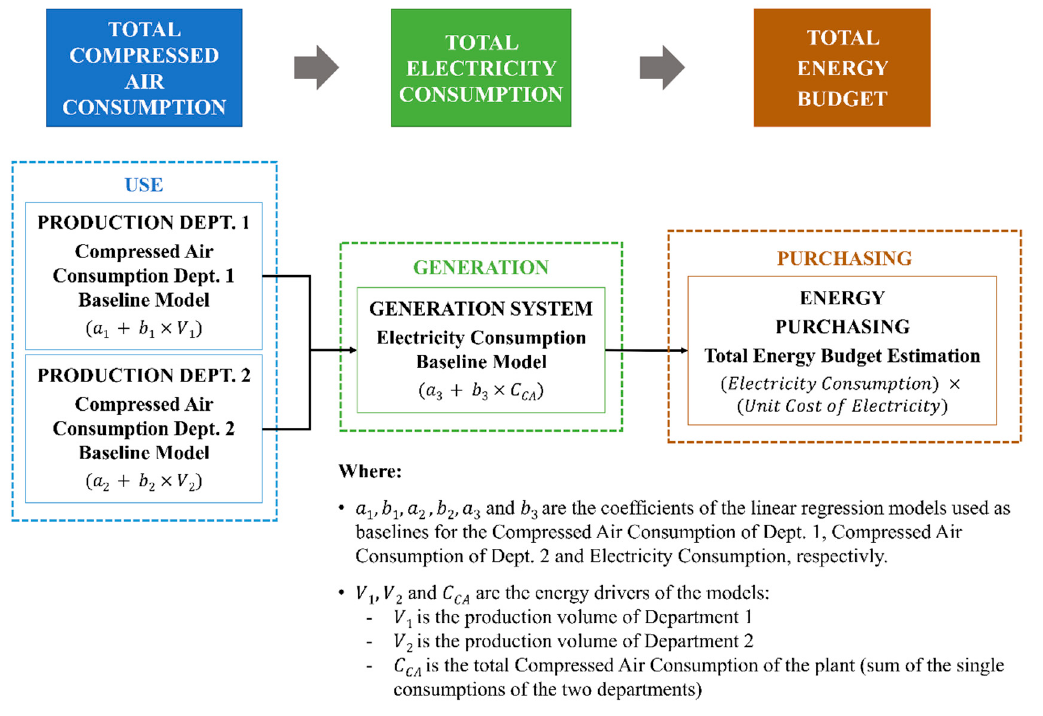
Figure 12. Schematic representation of the energy accounting methodology proposed to predict the energy budget related to the use of compressed air in the production plant. Table 3. Estimated compressed air budget for the considered